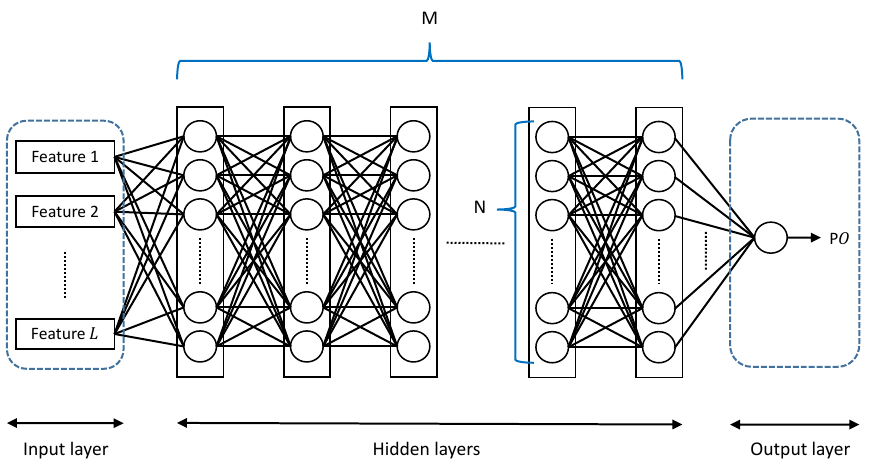
Figure 10. The Multilayer Perceptron (MLP) architecture.